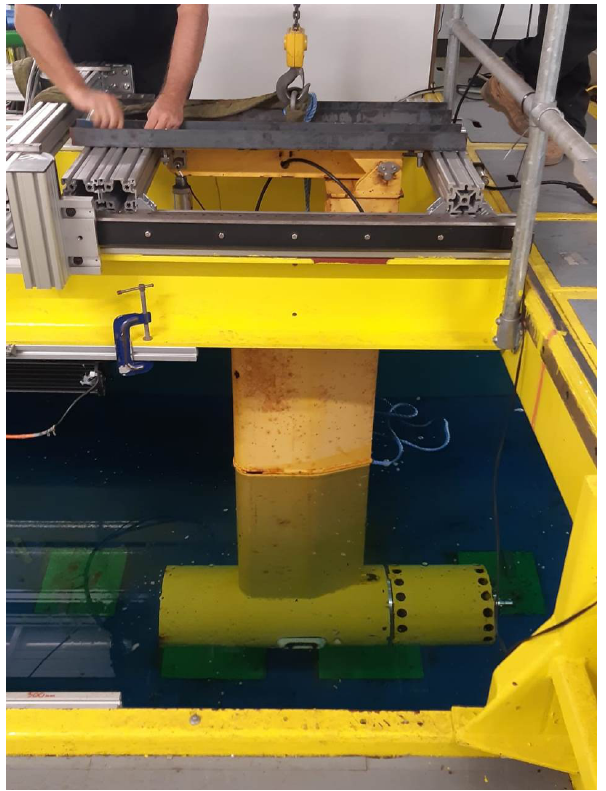
Figure 4. Mounting frames used to support the turbine to the main